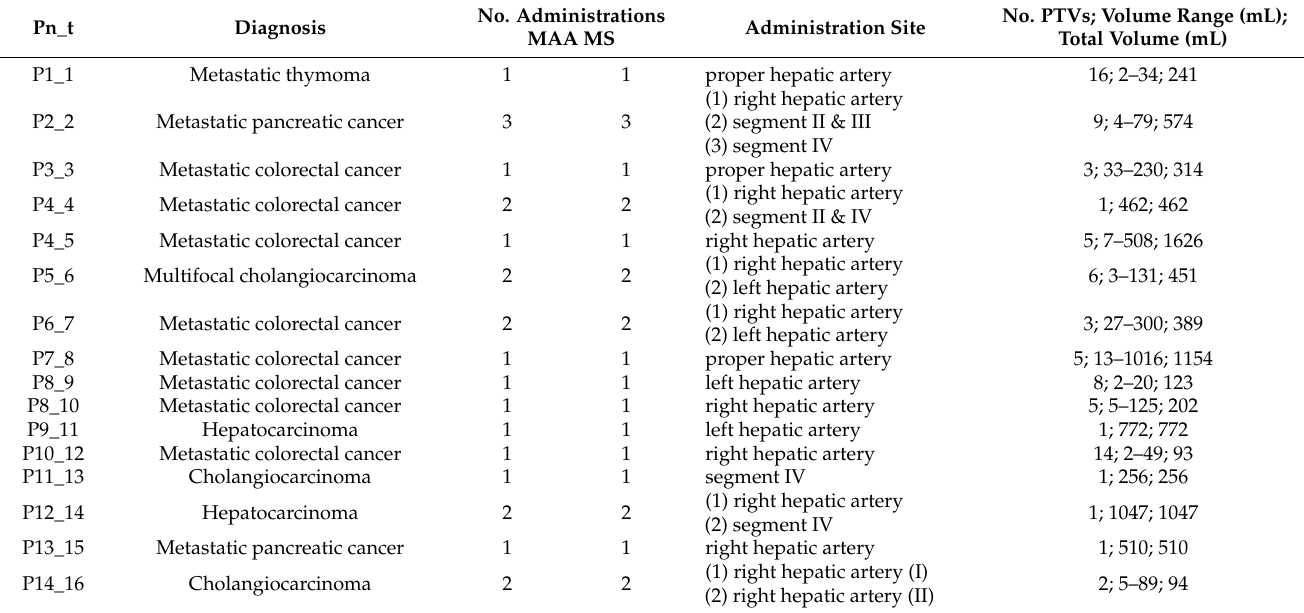
Table 1. Eligible patients (n) and RE treatments (t) included in this work and PTV